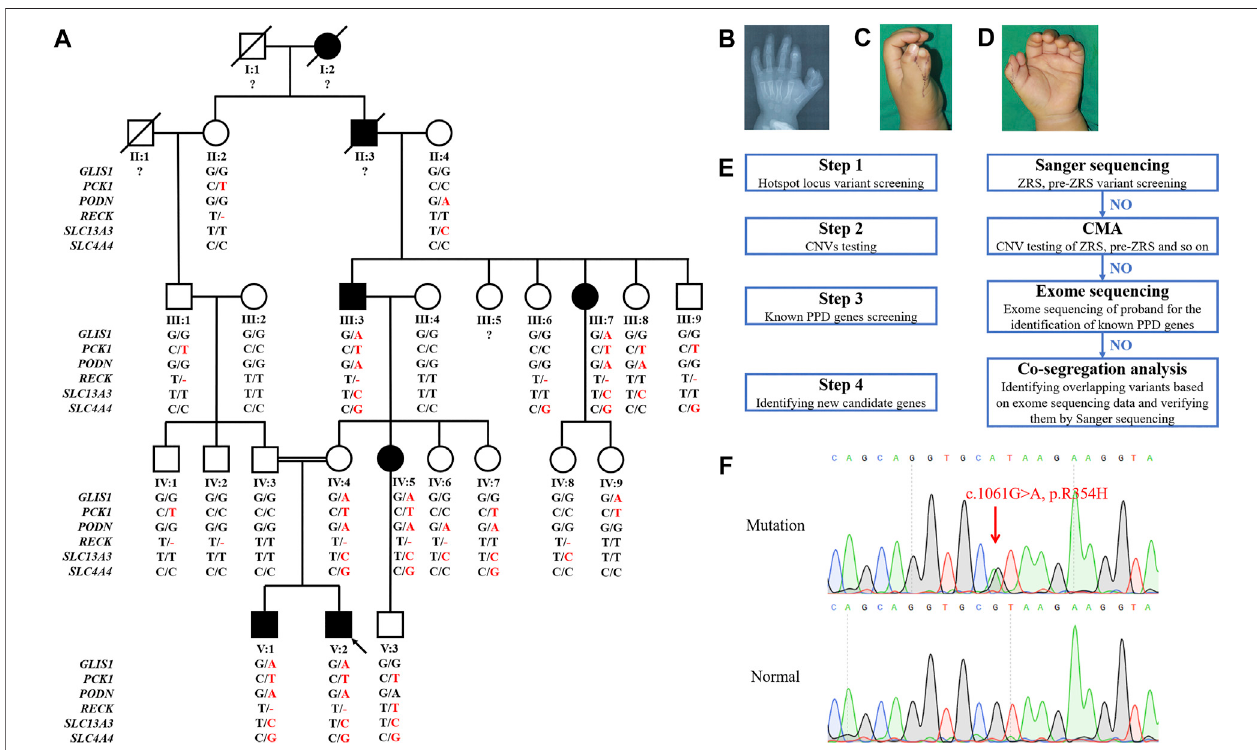
FIGURE 1 | Pedigree, symptoms, and stepwise genetic analysis of the PPD001 family. (A) Pedigree of PPD001 family with seven patients. The black symbols represent the affected members, and the arrow indicates the proband. Genotypes are identi fi ed by letters and a slash, with red letters representing variants. Question marksrepresentunknowndataorsymptoms. (B – D) TheprobandwasaffectedbyPPDI. (E) Thestepwisegeneticanalysisstrategy. (F) Sangersequencingresultsofthe GLIS1 variant (c.1061G > A, p.R354H).